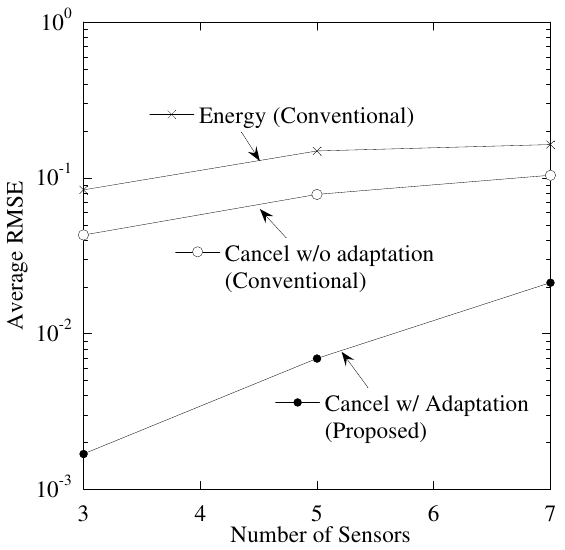
Figure 9. Performance between number of sensors and